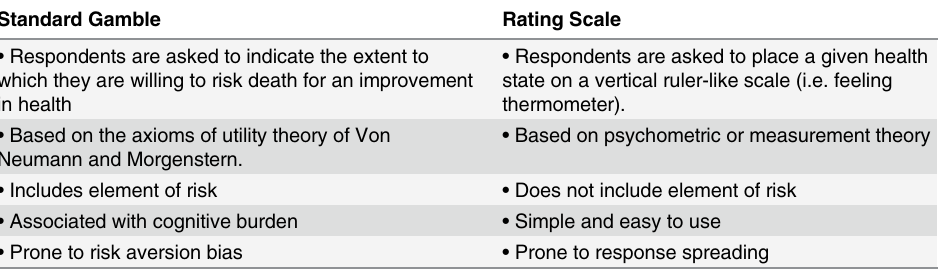
Table 1. Summary of standard gamble and rating